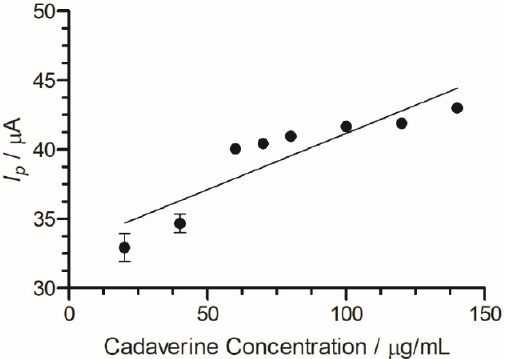
Figure 7. Cadaverine concentration (3–150 µg/mL) I p at C-MWCNT/DAO/EDC-NHS/GA SPE vs. Ag/AgCl reference electrode, with linear ranges identified at low and high concentrations of cadaverine.